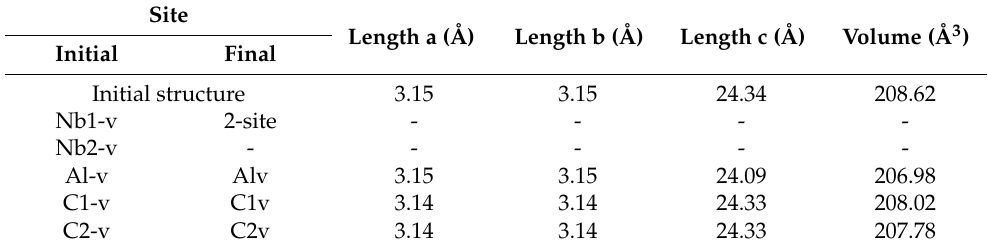
Table 2. The changes of crystal structure for H incorporation into different vacancies of Nb 4 AlC 3 .